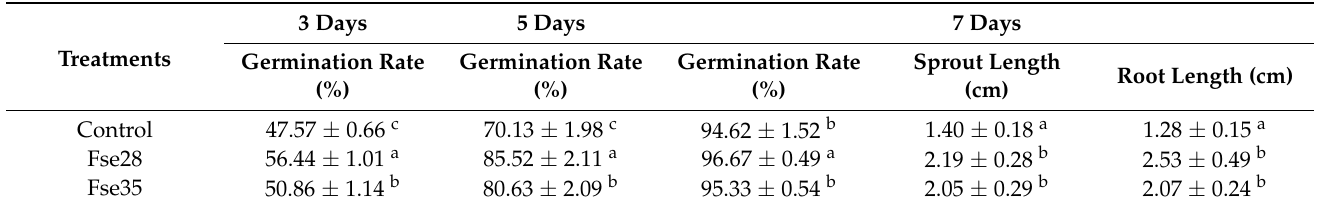
Table 3. Effects of inoculation with two putative PGPE strains on rice seed germination.